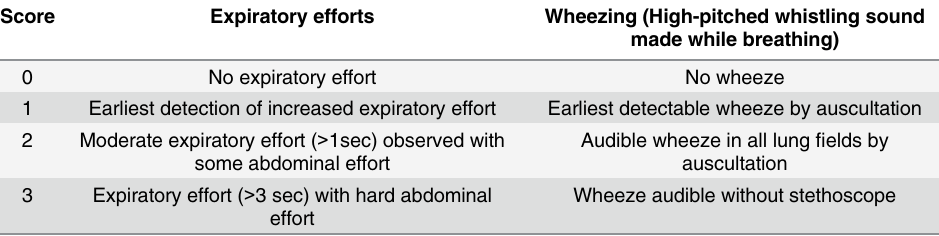
Table 1. Scoring criteria for lung function by